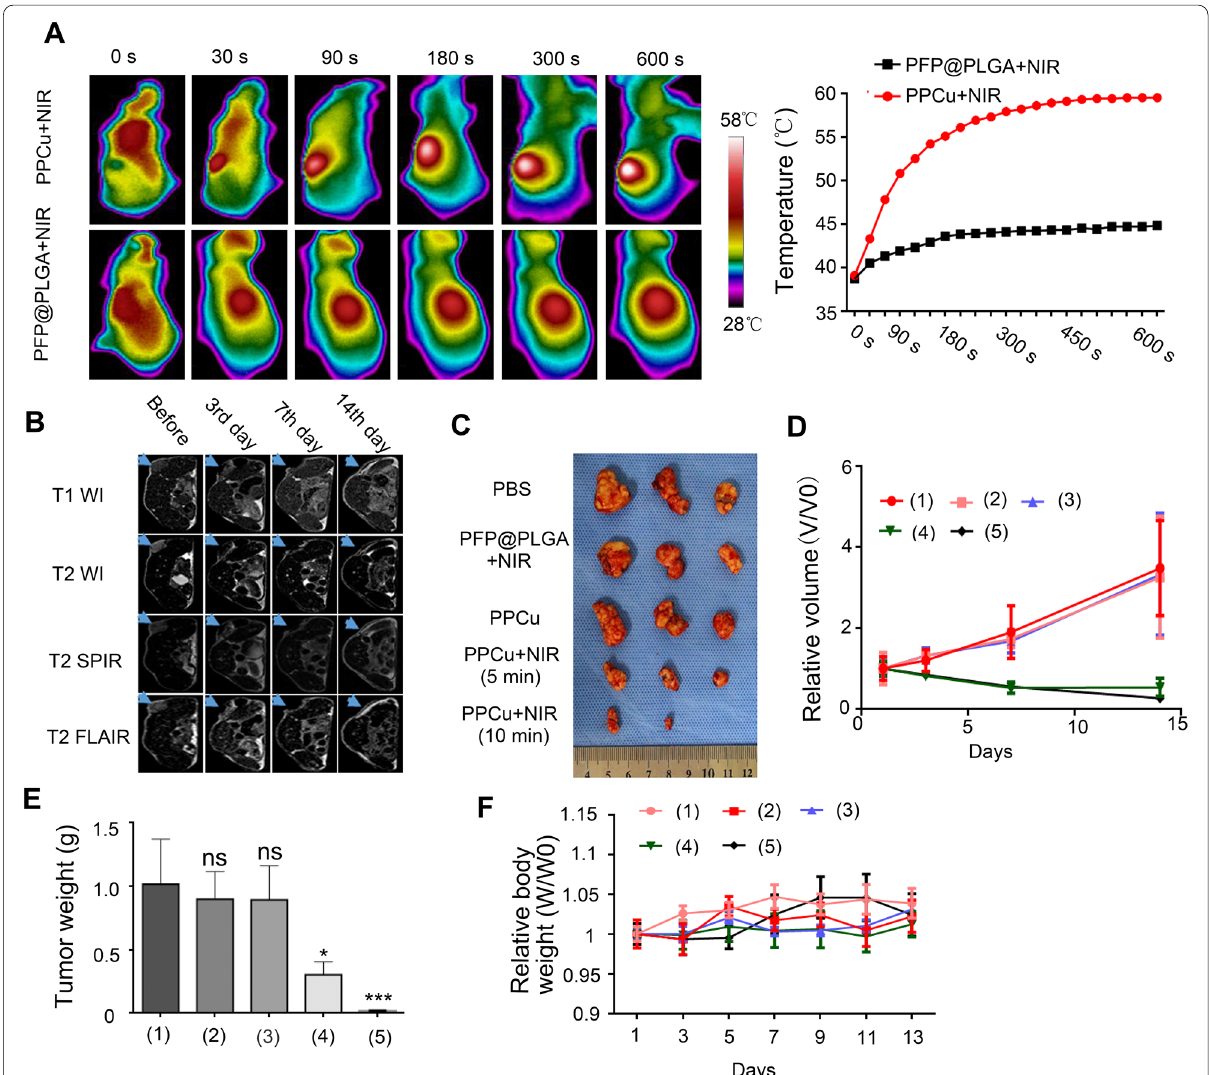
Fig. 4 PPCu-mediated PTT ablates HCC tumor in vivo. A Thermographic images and corresponding temperature levels of tumor regions under NIR laser irradiation within 10 min. B MRI of mice with tumors before and after treatment at the 3rd day, 7th day and 14th day, the arrows indicating the location of tumors. C Photographs of excised tumors from mice with different treatments at the 14th day. D Relative volume of tumors before and after treatments. (1), (2), (3), (4), and (5) represent PBS, PFP@PLGA NIR for 10 min, PPCu, PPCu NIR irradiation for 5 min, and PPCu NIR irradiation + + + for 10 min, respectively. E Average weights of tumors at the 14th day after treatment. (1), (2), (3), (4), and (5) represent PBS, PFP@PLGA NIR for + 10 min, PPCu, PPCu NIR irradiation for 5 min, and PPCu NIR irradiation for 10 min, respectively. F Relative body weight of mice before and after + + different treatments. (1), (2), (3), (4), and (5) represent PBS, PFP@PLGA NIR for 10 min, PPCu, PPCu NIR irradiation for 5 min, and PPCu NIR + + + irradiation for 10 min, respectively. Data are presented as the mean SD of three independent experiments. *compared with the control, p < 0.05. ** ± compared with the control, p < 0.01. *** compared with the control, p <